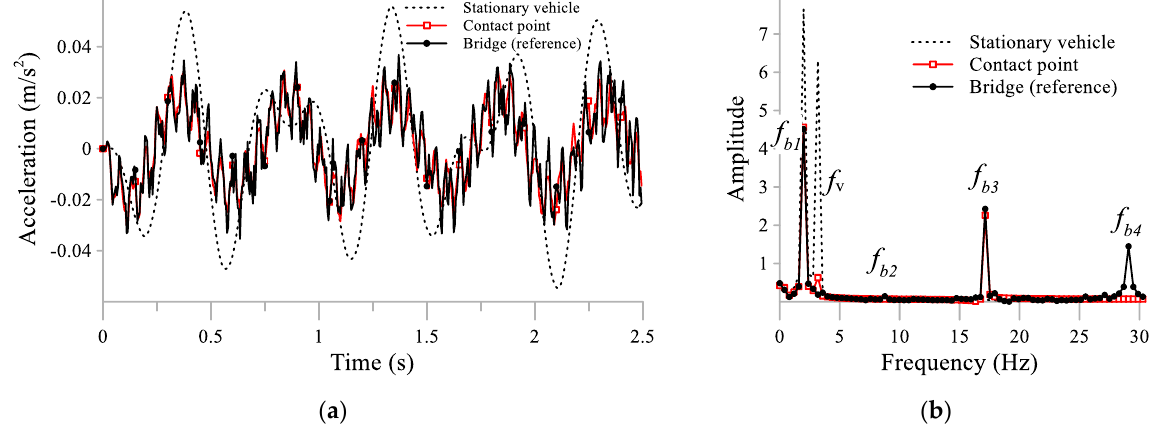
Figure 7. Dynamic response of the stationary vehicle at 3.18 Hz, along with its contact-point and bridge ( a ) acceleration responses at the mid-span and ( b ) the acceleration spectra.